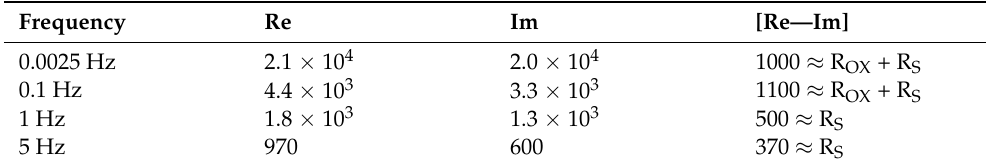
Table A5. The Difference ([Re—Im]) in the Frequency Range of 0.0025 Hz ≤ f ≤ 5 Hz in Zn Test at a Potential of − 623 mV.